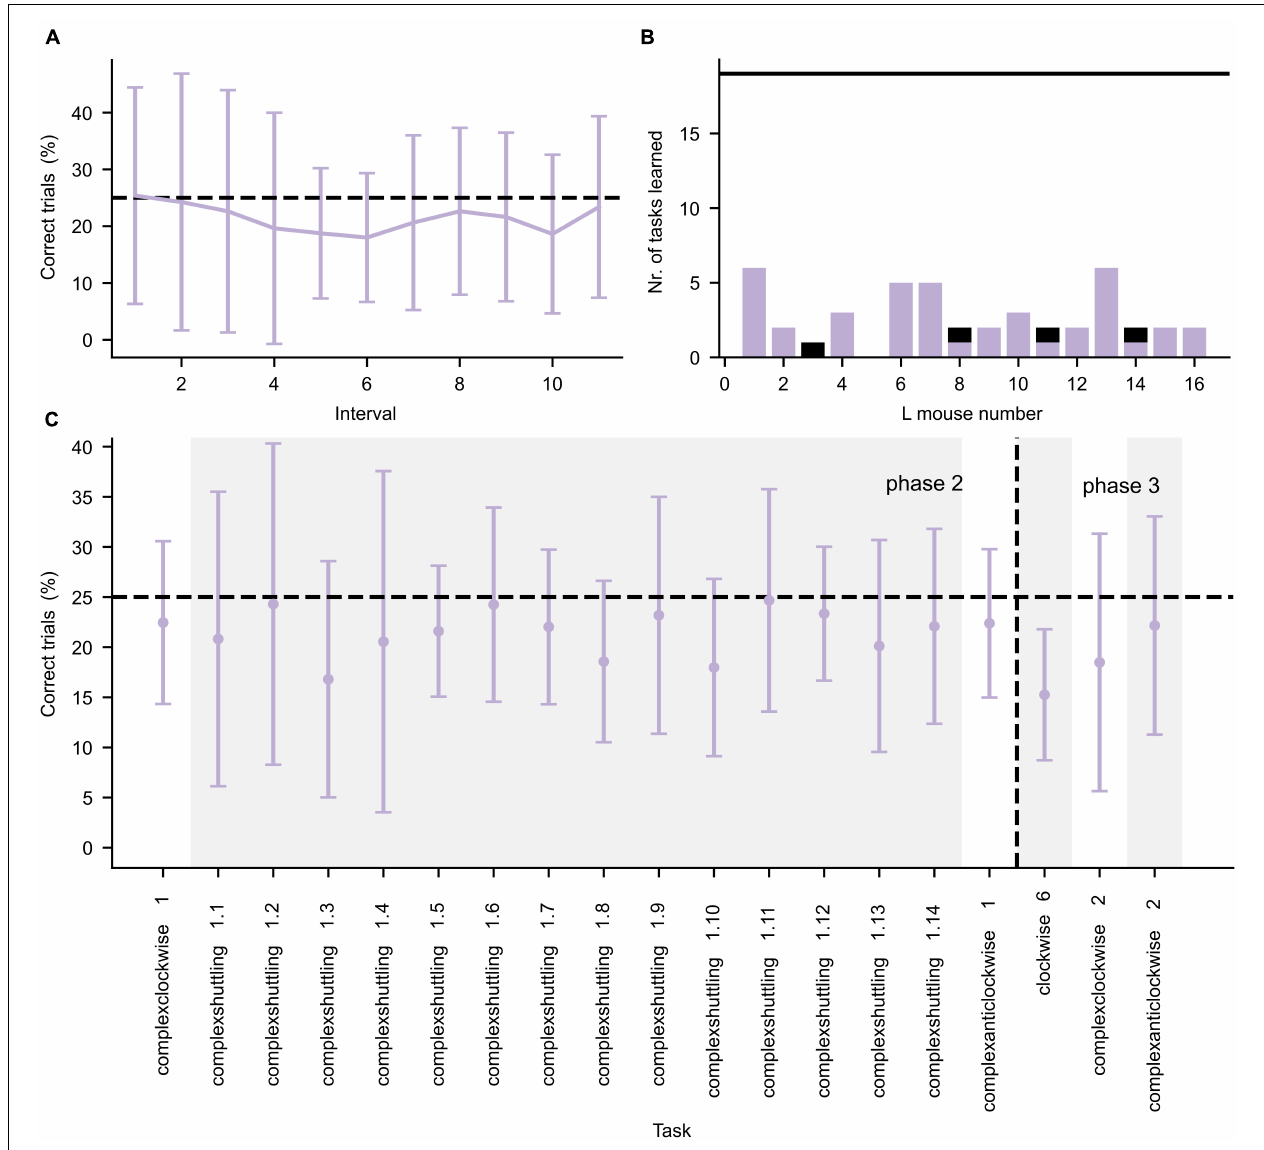
FIGURE 4 | Performance during the second and third IntelliCage phase. (A) Average performance ( ± standard deviation, n = 16) of all L mice for the first 550 trials of the Complexclockwise 1 learning task, divided in intervals of 50 trials per interval. (B) Number of tasks for which the L mice successfully achieved the learning criterion. The black horizontal line represents the total number of tasks. The purple and black bars represent successful tasks during phase 2 and 3, respectively. (C) Average performance ( ± standard deviation, n = 16) is given by the error bar data points. Changes in task are separated by alternating white and gray background color. The learning tasks are represented in chronological order. The horizontal dashed lines in both panels (A,C) represent the chance level of correct performance in each task. The vertical dashed line in panel (C) represents the separation between IC phase 2 and